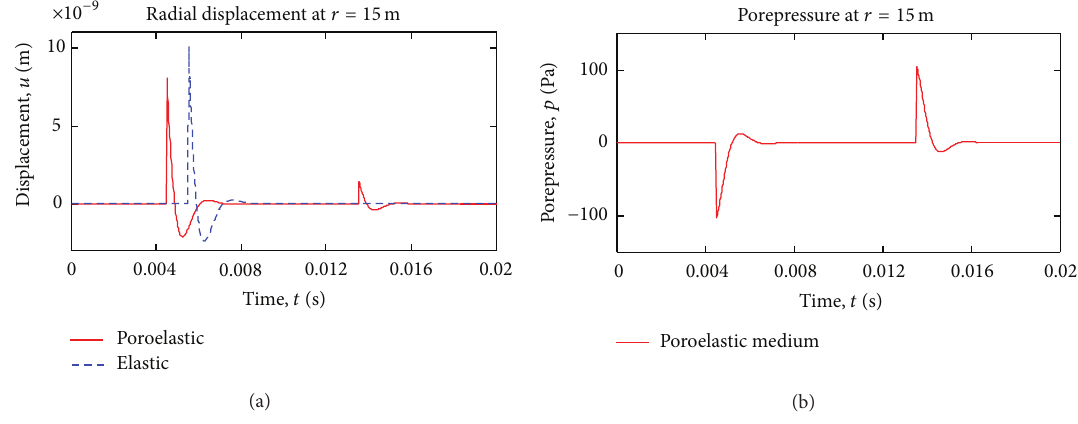
Figure 3: Time variation of radial displacement and pore pressure, blast (Dirac) pulse case.